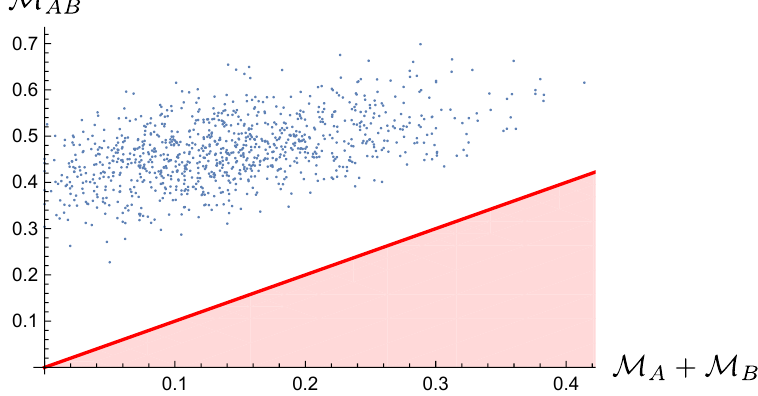
Figure 6 . A scatter plot of the global mana, M AB ≡ M ( ρ ) , against the sum of subsystem mana, M A + M B , (where M A = M ( ρ A ) and M B = M ( ρ B ) ) for 1000 pseudo-random states of two qutrits (i.e. k = 2 ). The region violating super-additivity, (4.21), is shaded in red. The mixed states, ρ ,